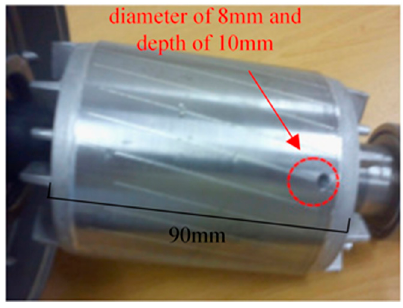
Figure 9. Broken rotor bar.